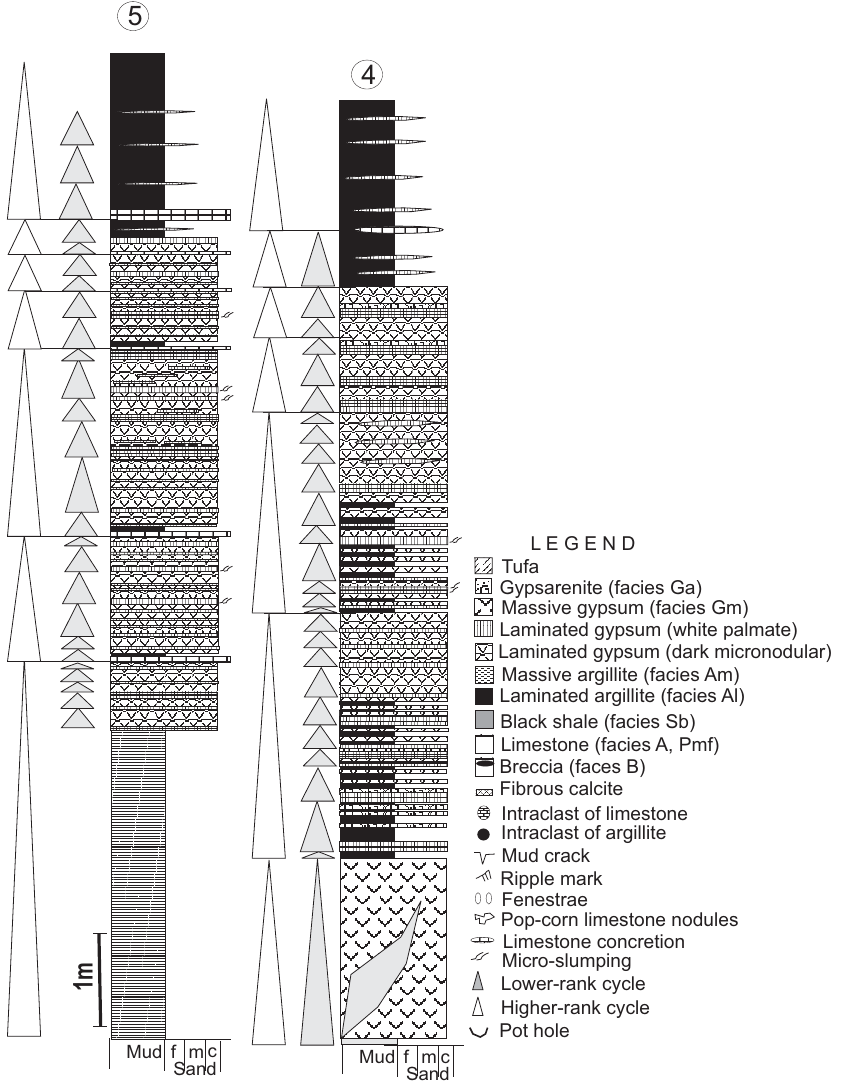
Fig. 2 – Lithostratigraphic profiles representing the evaporite facies of the Codó Formation in the Grajaú area. (See figure 1 for